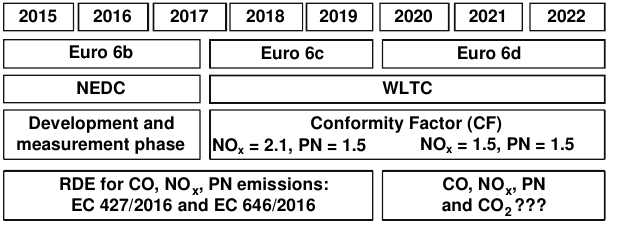
Fig. 1. RDE tests requirements in Europe [4, 5]